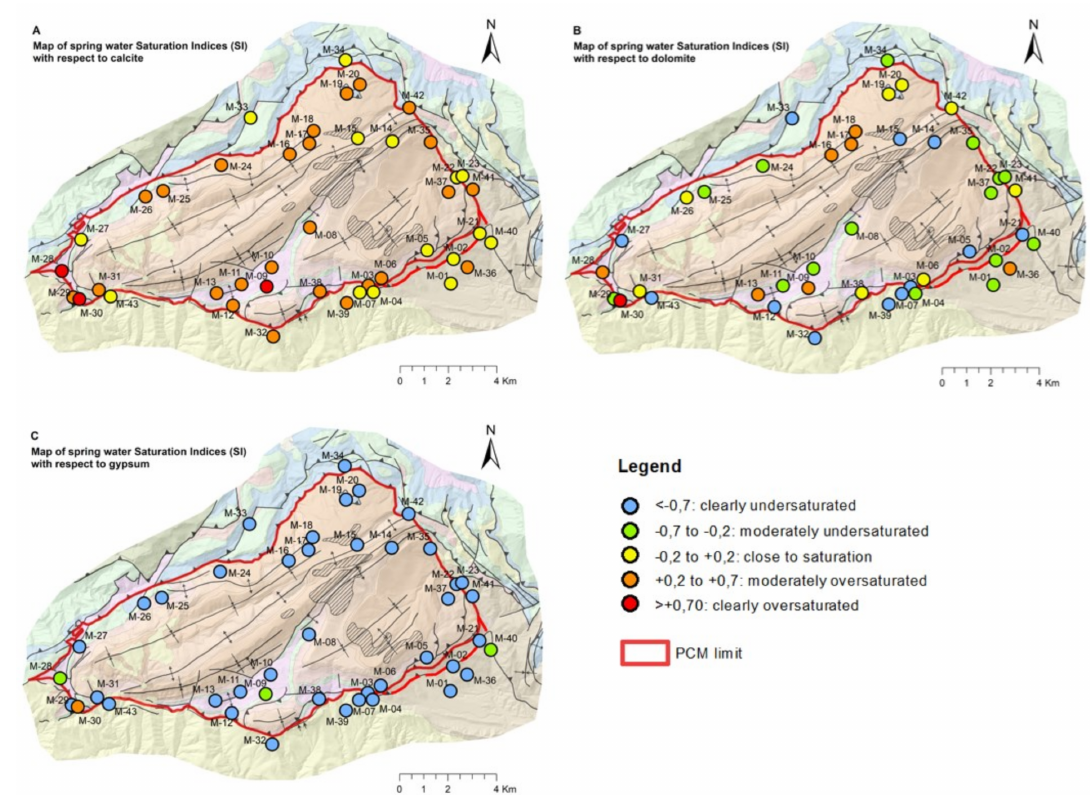
Figure 4. Saturation index maps relative to calcite ( A ), dolomite ( B ), and gypsum ( C ) in GW for the sampled